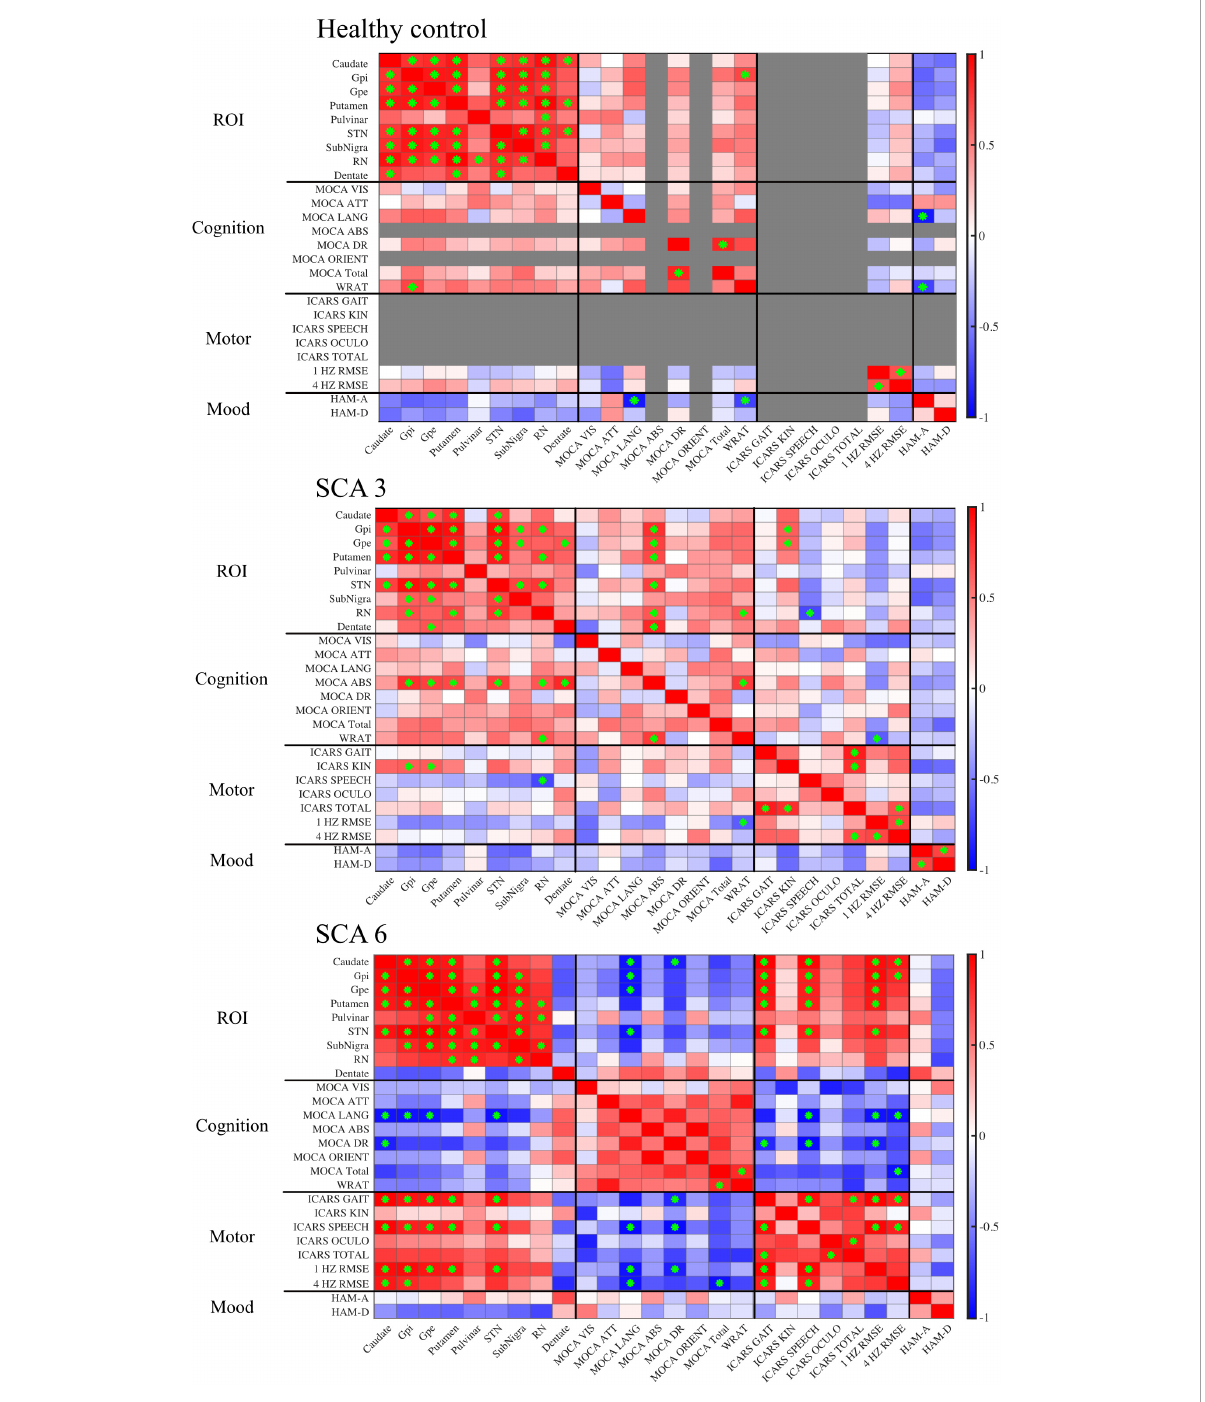
FIGURE4 Correlation matrices show associations between QSM-derived normalized susceptibility mass (mean magnetic susceptibility × Corrected ROI Volume in the unit of 10 3 ppm × mm 3 ) in the ROIs and cognitive, motor, and mood assessments. Red, positive correlation; blue, negative correlation. Green asterisk indicates p -value < 0.05. In controls, scores were grayed out when there was no measurement (ICARS) or no variability across participants (MOCA abstract thinking and orientation). MOCA naming was excluded altogether because there was no score variability for all three groups. Gpi, globus pallidus internal; Gpe, globus pallidus external; STN, subthalamic nucleus; SN, substantia nigra; RN, red